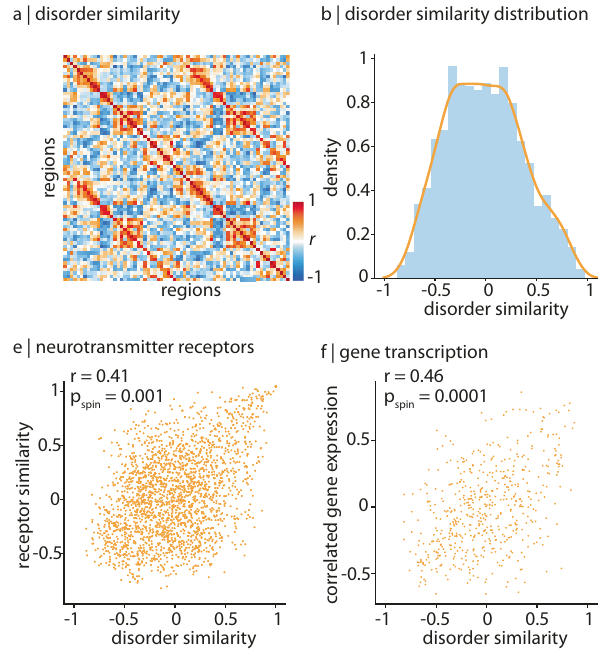
Fig. 5 | Brain regions with similar molecular annotations are similarly affected acrossdisorders.a Disordersimilaritywascomputedasthepairwisecorrelationof regionalcorticalabnormalityacrossallthirteendisorderssuchthatpairsofregions with high disorder similarity are similarly affected across disorders. b A histogram depicting the upper triangle of the disorder similarity matrix. c Disorder similarity issigni fi cantlycorrelatedtomolecularattributesimilarity(Pearson's r (2276)=0.45, p spin =0.0001,CI=[0.42,0.49],two-tailed). d Disordersimilarityisnotsigni fi cantly correlated with connectomic similarity (Pearson's r (2276)=0.25, p spin =0.063, CI=[0.21,0.29], two-tailed). e Disorder similarity is signi fi cantly correlated to neurotransmitter receptor similarity (Pearson's r (2276)=0.41, p spin =0.001, CI= [0.38,0.45], two-tailed). f Left hemisphere disorder similarity is signi fi cantly